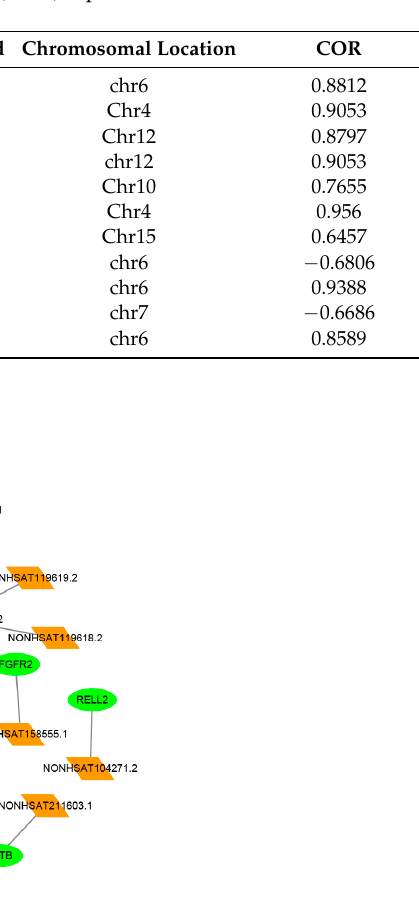
Figure 6. Co-expression network for the DE lncRNAs-mRNAs. A total of 38 DE lncRNAs and 29 mRNA from GO and KEGG (significant enrichment, p < 0.05) were used for co-expression analysis by the Cytoscape software. Known/novel mRNA are shown in green/light green and known/novel lncRNA are shown in brown/pink.